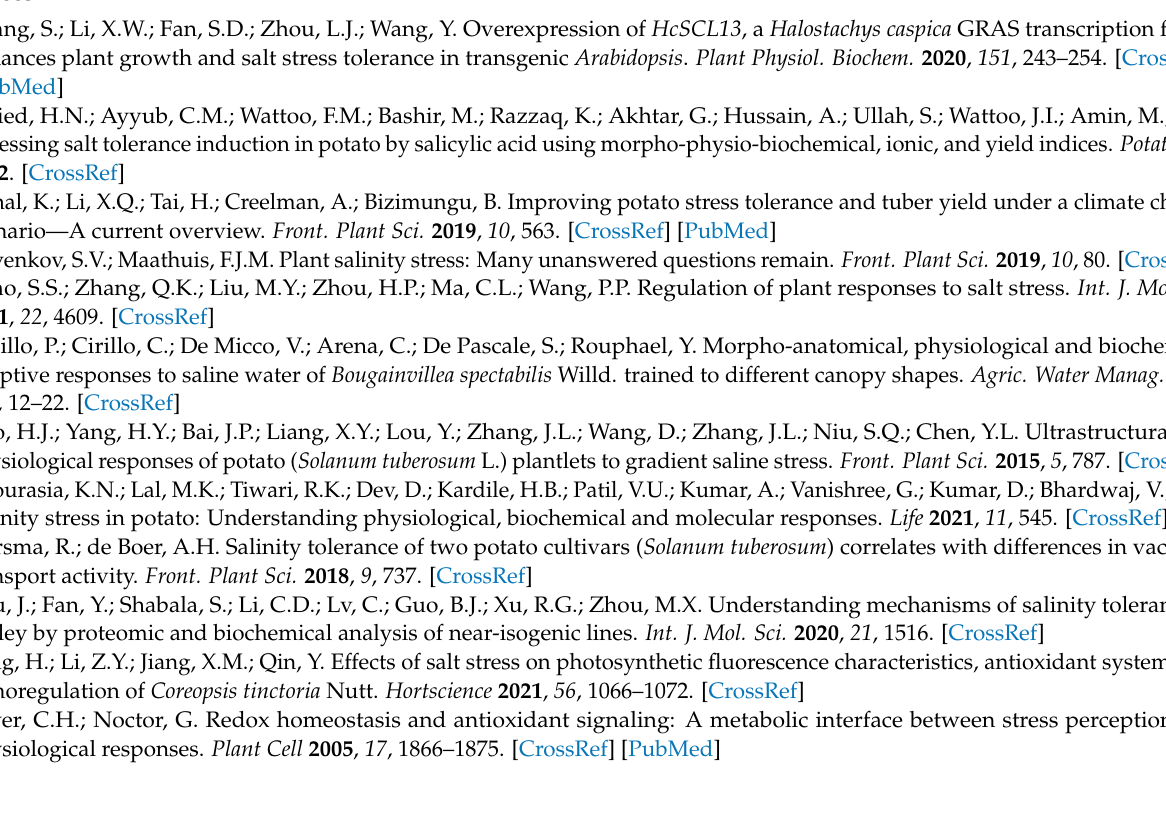
4 weeks; Table S1: Salinity-tolerance coefficient of different indicators; Table S2: Correlation matrix of seven indicators; Table S3: Characteristic vectors of normalization by principal component